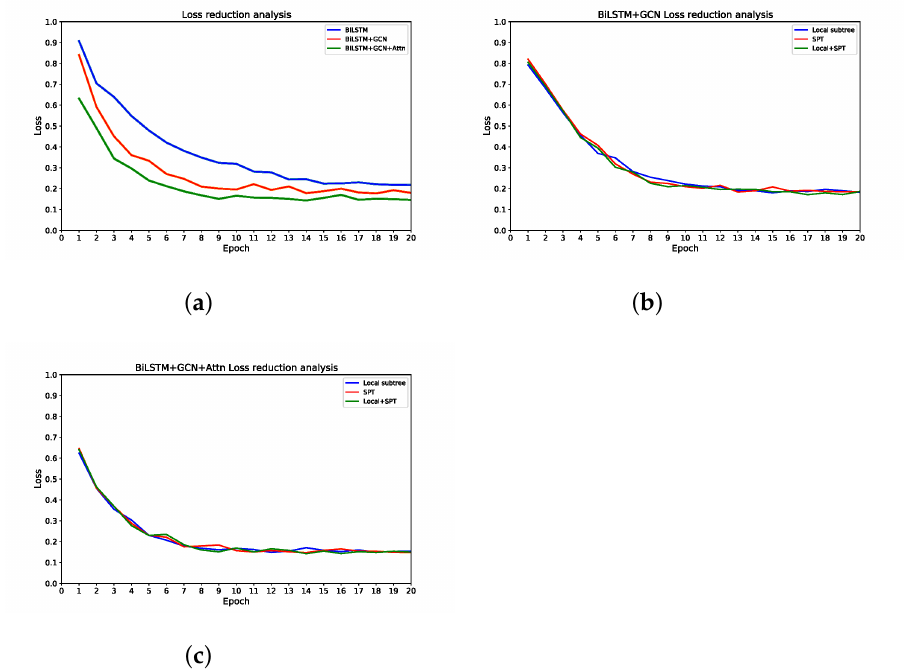
Figure 7. Comparison of training loss reduction for different models on the same dataset. ( a ) Loss reduction plots for different models with the same parameters. ( b ) Comparison chart of loss reduction for fusing three pruning operations on the BILSTM+GCN model. ( c ) Comparison chart of loss reduction for fusing three pruning operations on the BILSTM+GCN+Attn